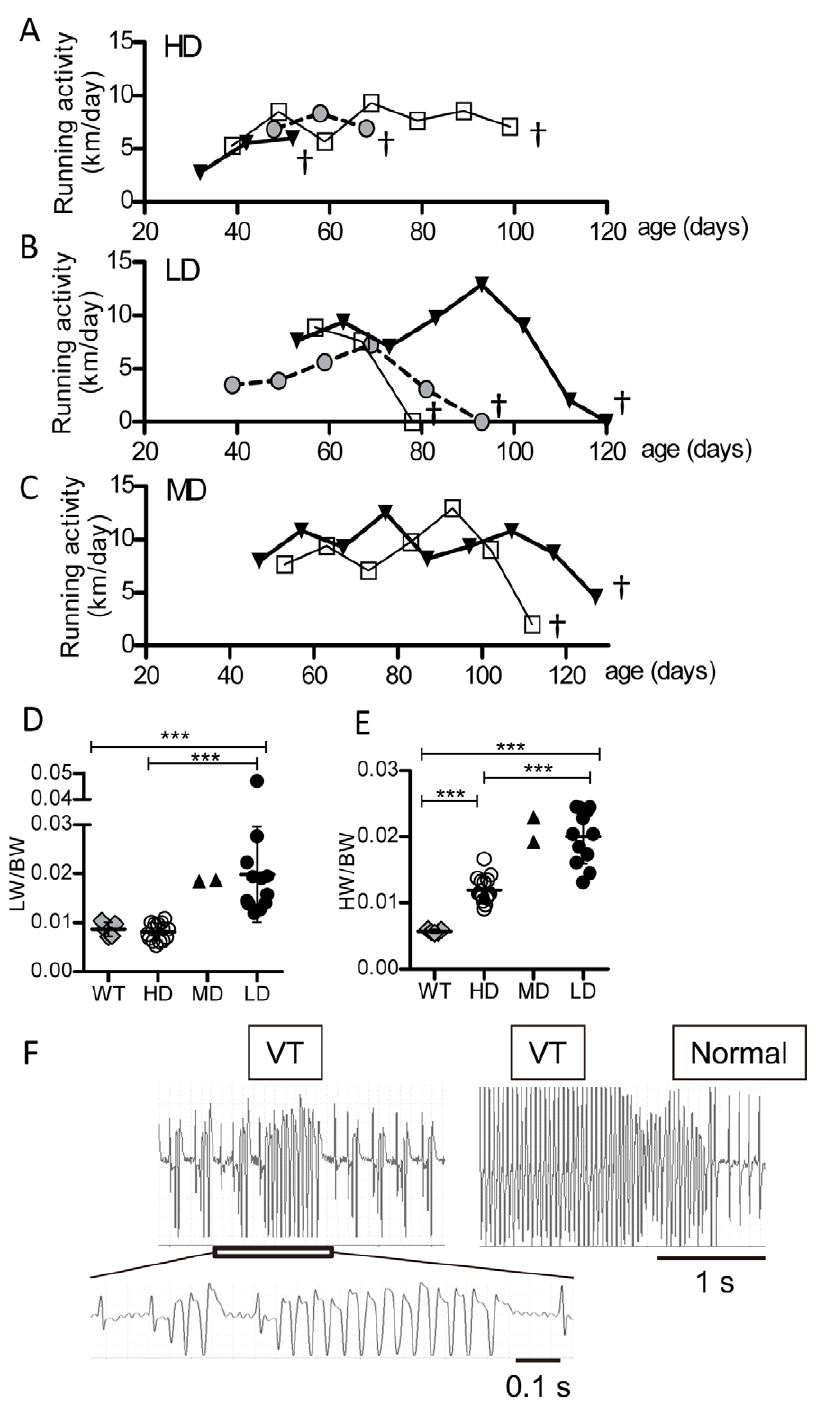
Figure 6. Time courses of voluntary running activity and causes of death in DCM mice. A. Typical time courses of running activity in three mice that maintained high activity ( . 5 km/day) and died suddenly. B. Instances of three mice that decreased running activity to , 1 km/day and died. C. Instances of two mice that gradually lost running activity to between 1 and 5 km/day and died. Different symbols indicate different individual mice. D and E . LW/BW ( D ) and HW/BW ( E ) ratios in mice found dead in their cage. HD: mice with running activities of . 5 km/day before death ( n =15). MD: mice that showed last running activity between 1 and 5 km ( n =2). LD: mice with activity of , 1 km/day before death ( n =12). Bars are mean 6 SD. *P , 0.05, **P , 0.01, ***P , 0.001. F. Typical ventricular arrhythmia recorded with telemetry ECG system from a 2.5-month-old mouse with high wheel running activity. Inset: ECG record with expanded time scale. Ventricular tachycardia (VT) repetitively occurred for 15 min in this mouse.